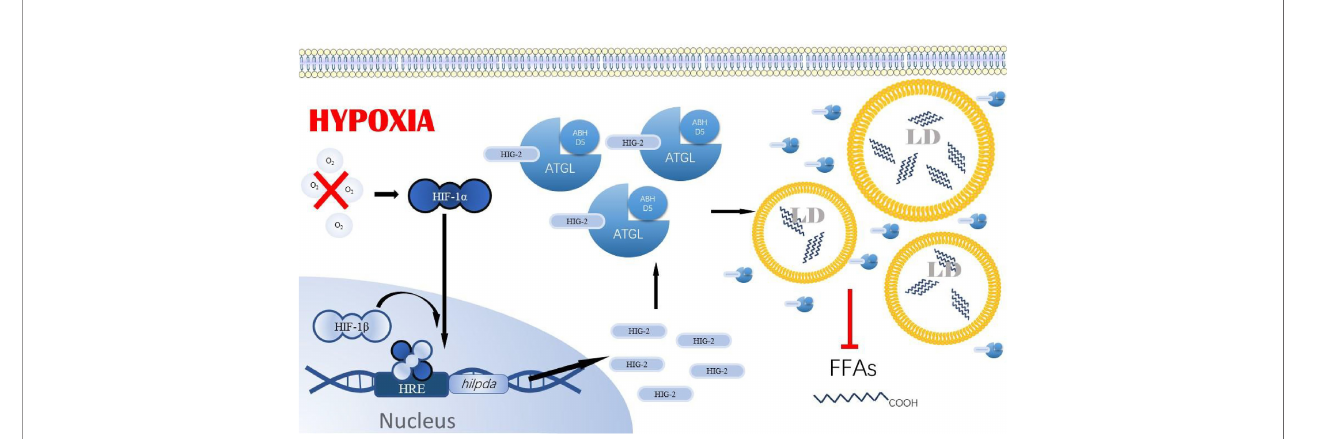
FIGURE 2 | HIF-1/HIG-2/ATGL axis. Under hypoxia, HIF-1 a - la can enter the nucleus of tumor cells and bind to HIF-1 b , forming a stable dimer. This dimer binds to the HRE region upstream of hilpda, allowing tumor cells to express HIG-2 in large amounts. Even in t h e presence of ATGL binding to coactivator ABHDS, HIG-2 can still bind to ATGL, resulting in the inability of ATG L to anchor to the LD membrane and the inhibition of activity. Eventually, there is a signi fi cant accumulation of tri glycerides in tumor cells, resulting in lipid droplet accumulation. HIF-1 a , Hypoxia-inducible factor I a ; HIF-1 b , Hypoxia-inducible factor 1 b . HRE, Hypoxia response element; ATGL, Adipose triglyceride lipase; HIG-2, Hvpoxia-inducible lipid droplet-associated. LD, Lipids droplet. FFAs, Free fanv